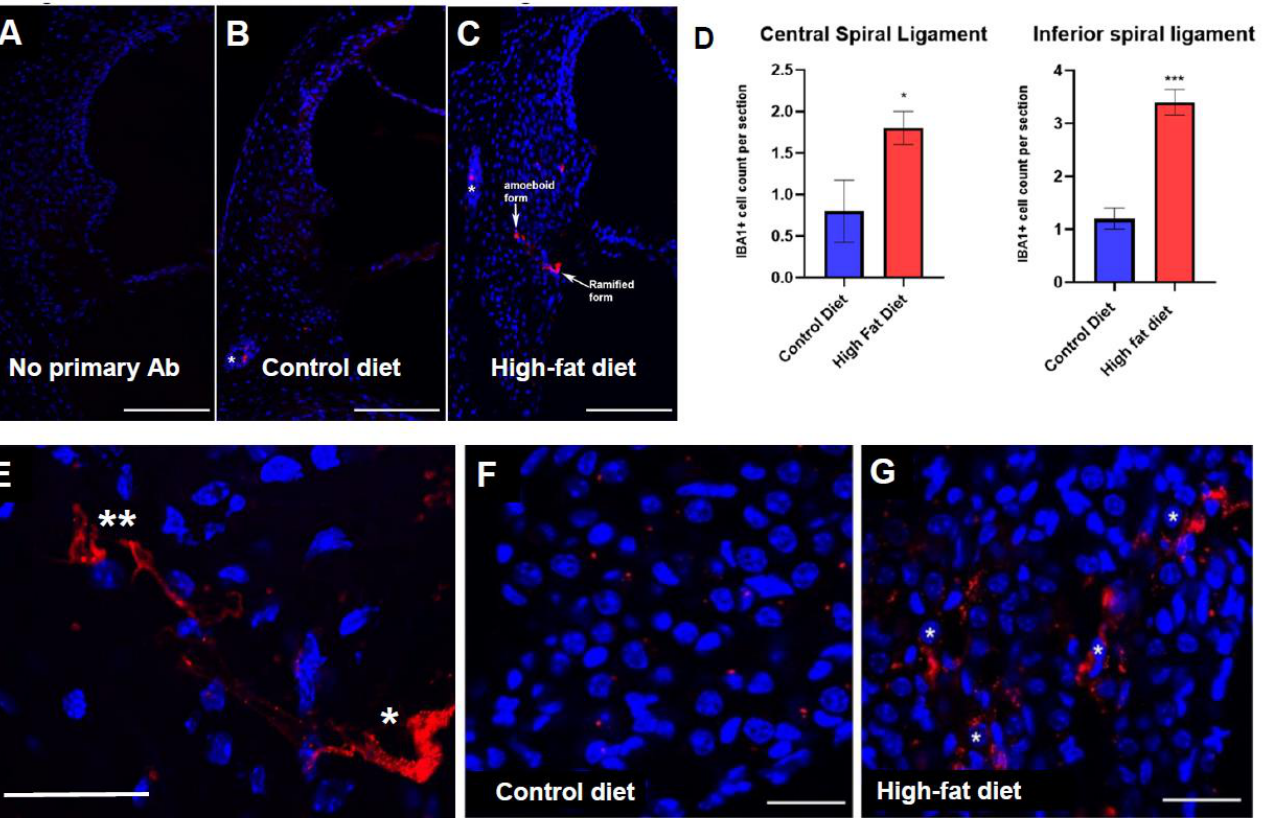
Figure 4. Iba1+ macrophages in the mouse cochlea. ( B , C ) Iba+ cells were observed in both diet groups but not in control cryosections stained with a normal IgG-Alexa 594 conjugate ( A ). In mice on a control diet ( B ), rare Iba1+ cells were located at the spiral ligament/otic capsule border (asterisk). In mice on a high-fat diet ( C ), Iba1+ cells were found mainly within the inferior spiral ligament (arrows). ( D ) The number of Iba1+ cells in HFD mice was higher than in CD mice in the central and inferior regions of the spiral ligament. Data presented as mean ± SEM ( n = 5 per diet group). * p < 0.05; *** p < 0.001; t -test. ( E ) Iba1+ macrophages displayed both ramified (*) and amoeboid (**) morphologies. ( F , G ) Iba1+ cells were also found in the spiral ganglion, predominantly in the HFD group ( G ). Scale bars, 100 μm ( A – C ), 30 μm ( E – G ).